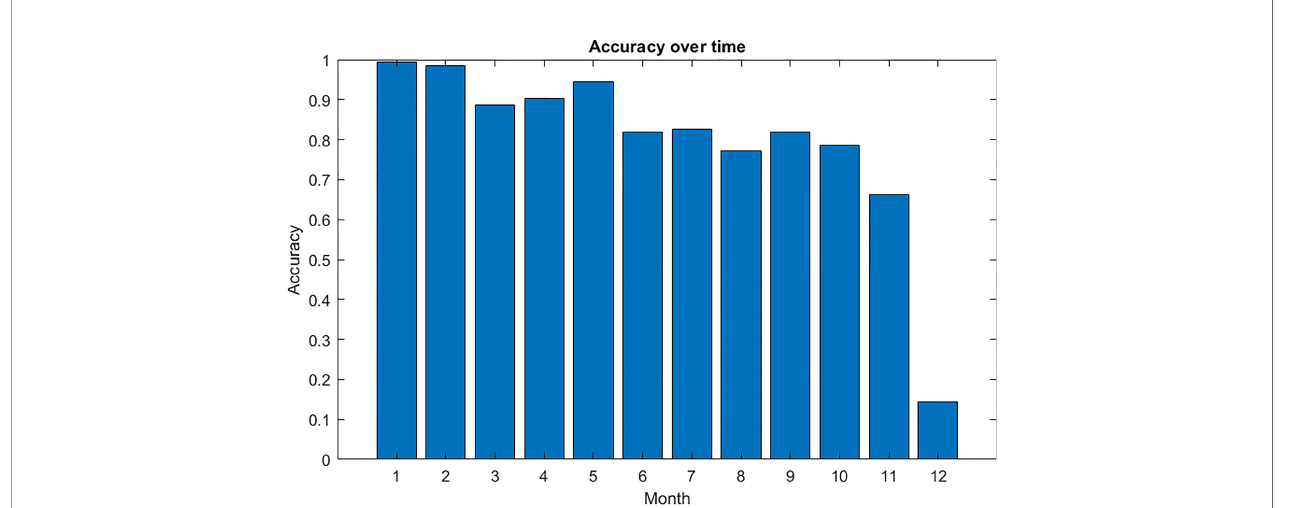
FIGURE 5 | Monthly progressive decrease of the averaged accuracy resulting from the experiment N.2 (30% training, 70% test).